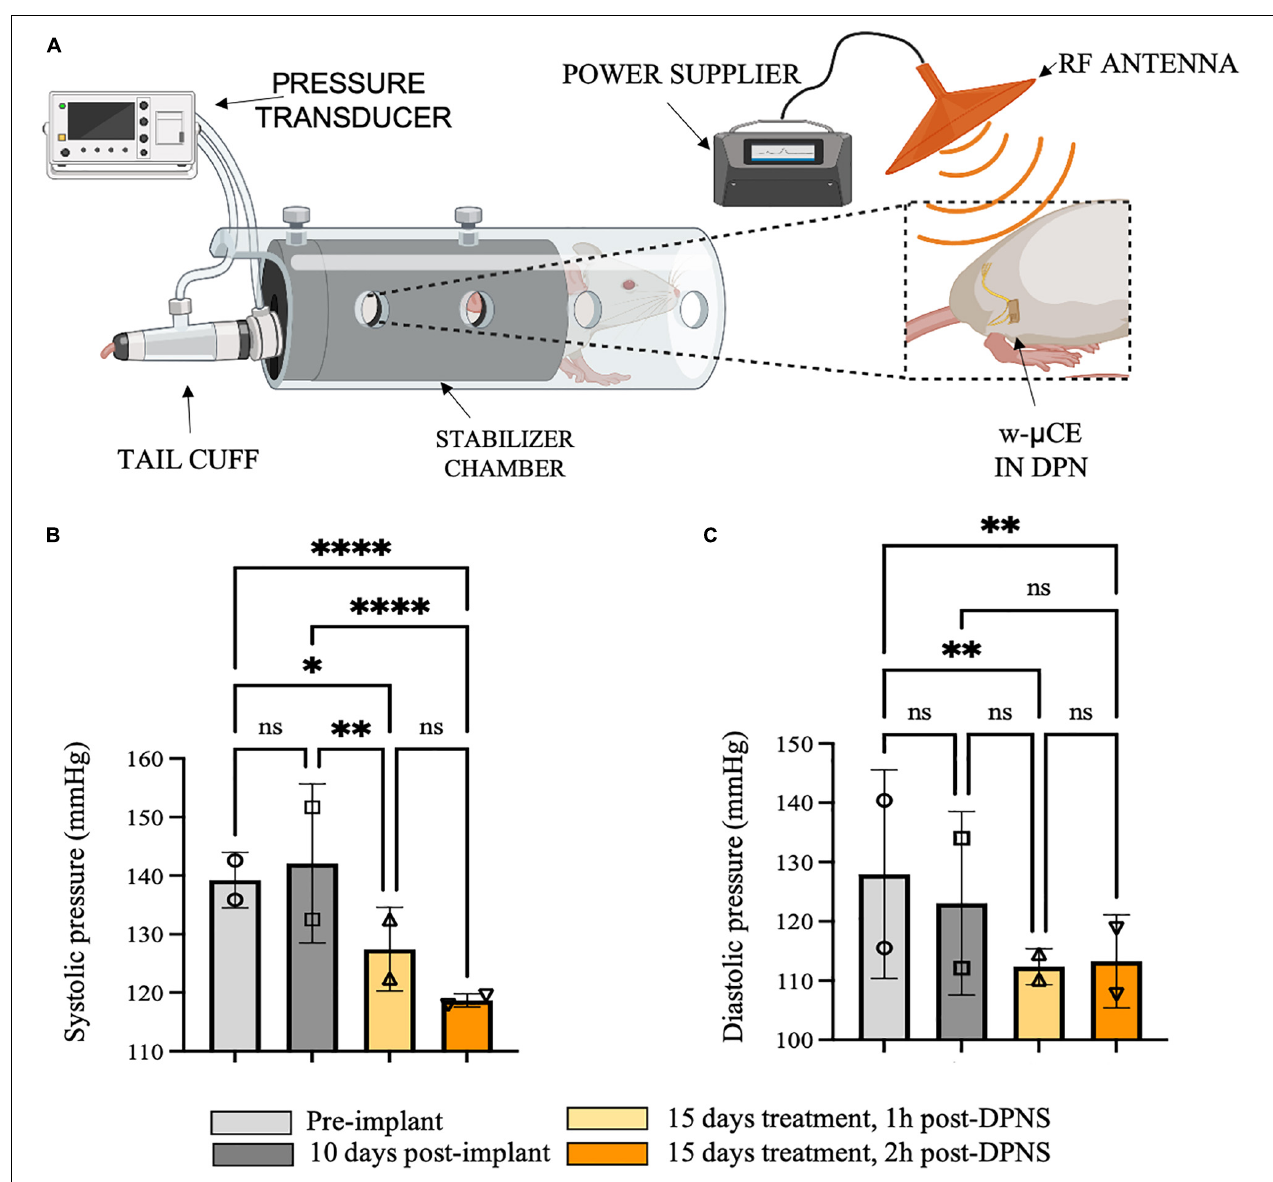
FIGURE 6 | Effect of sub-chronic DPNS on blood pressure in SHR awake animals. (A) Experimental setup; blood pressure was measured with a tail cuff in restrained and fully awake animals. The external antenna delivered pulses to the w-mCE on the DPN. (B,C) Multiple systolic and diastolic pressure measurements were taken during baseline (i.e., pre-implant and 10 days post-implant) and 15 days after daily 10-min DPNS treatment, at 1 and 2 h post-DPNS (8–19 measurements in two animals, * p < 0.05, ** p < 0.001, and **** p < 0.0001). DPN, deep peroneal nerve; DPNS, DPN stimulation; SHR, spontaneous hypertense rats; w-mCE, wireless micro-channel